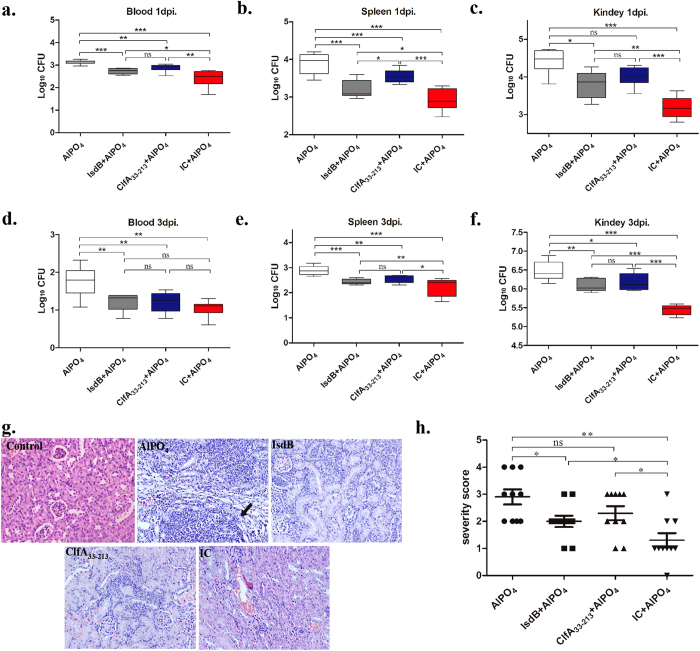
Immunisation with IC significantly reduced both organ bacterial burdens and pathology.Bacterial burdens in the blood, spleens and kidneys (n = 8) were calculated at 1 (a–c) and 3 days (d–f) post-infection. Representative results from one of three independent experiments were shown. Data were presented as box and whisters, and the medians were shown. Asterisks indicate significant differences between two groups (*P < 0.05, **P < 0.01, ***P < 0.001). (g) HE-stained kidneys from the AlPO4 group and recombinant vaccine immunised groups at 3 days post-infection were shown. BALB/c mice were immunised with recombinant proteins. Three days post-infection (5 × 108 CFUs), the kidneys were collected, and representative histopathological sections were shown (magnification = 400×). The kidney tissue of mouse without infection were used as control. Arrowheads indicate Staphylococcal abscesses. (h) Severity scores of kidneys (n = 10) from the AlPO4 group and recombinant vaccine immunised groups at 3 days post-infection were shown. Data were presented as scatter plots, and the means ± SEM were shown. Asterisks indicate significant differences between two groups (*P < 0.05, **P < 0.01).